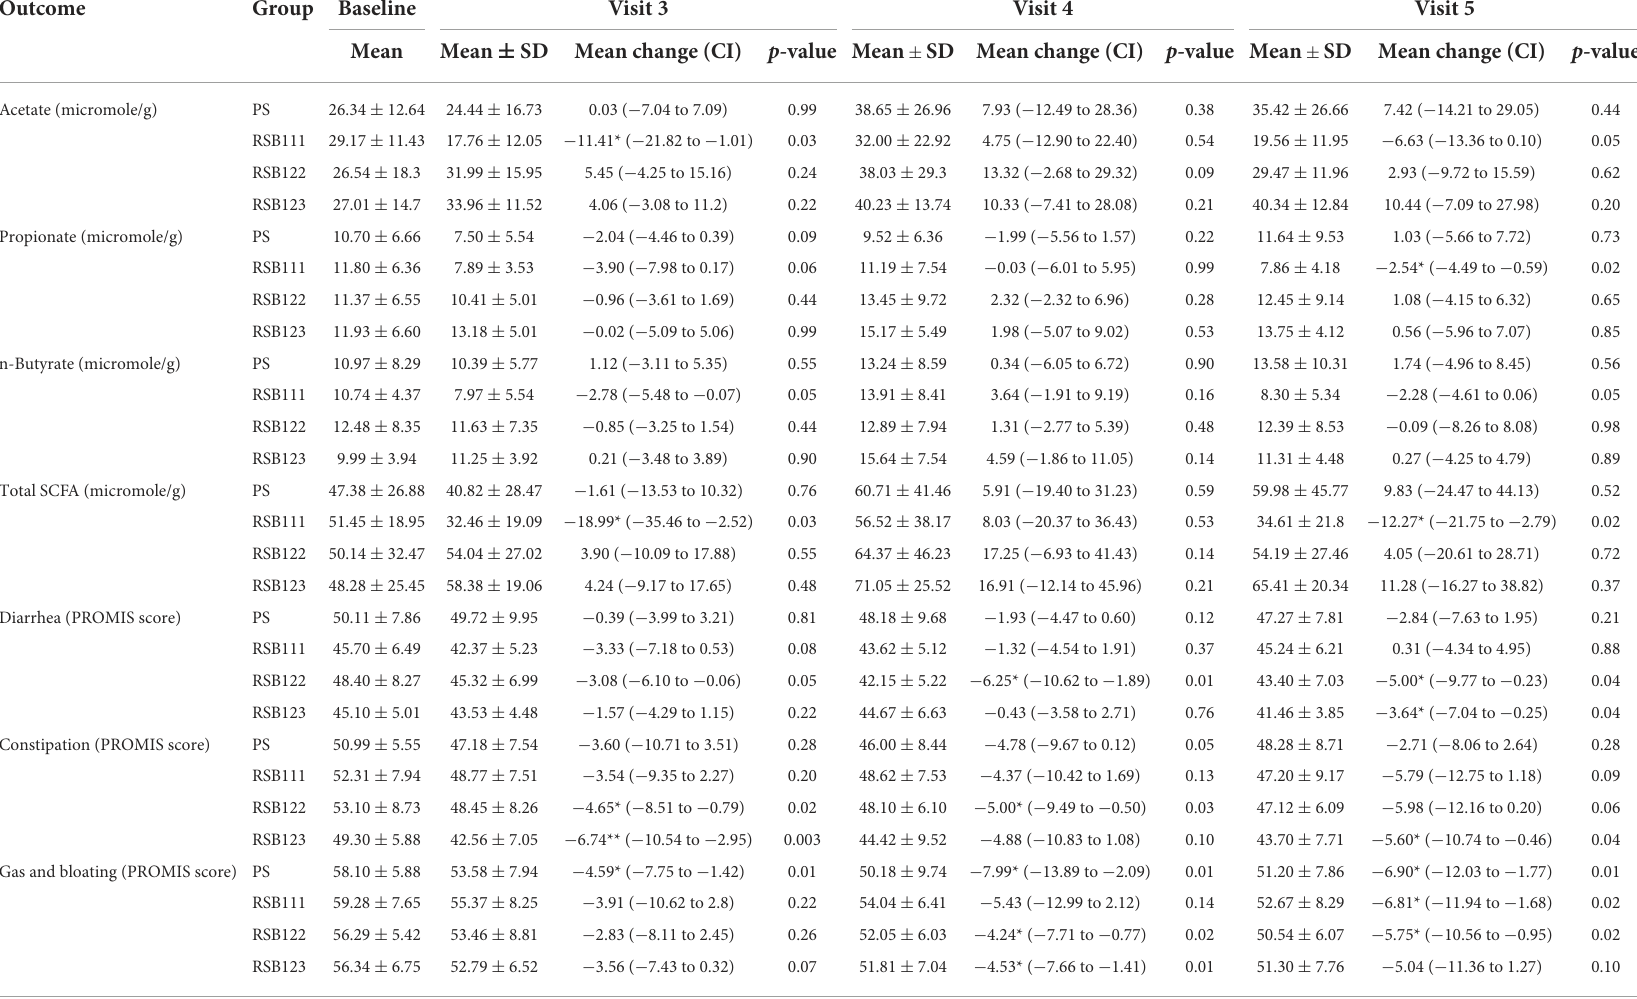
TABLE 2 Changes in SCFA and GI symptom outcomes during the study, ITT analysis. Outcome Group